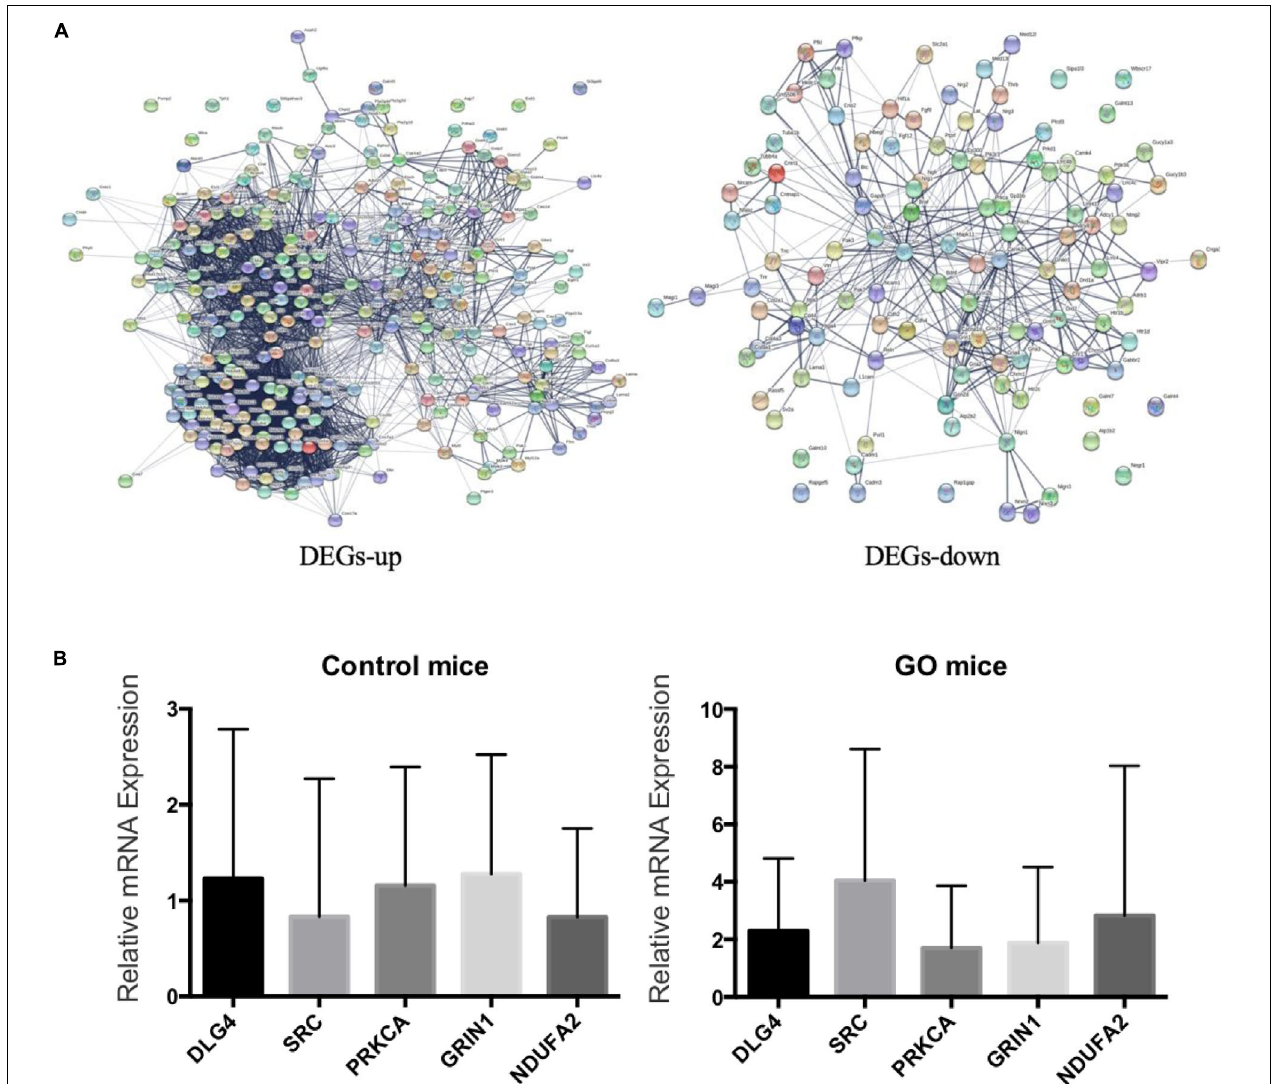
FIGURE 5 | Validation of DEGs. (A) Up- and down-regulated genes in PPI; (B) Validation of DEGs by